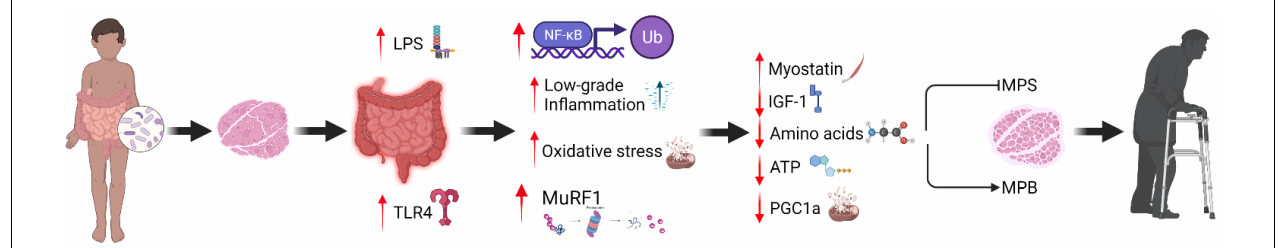
FIGURE 1 | Proposed mechanisms that underpin muscle anabolic resistance via changes in gut microbiota